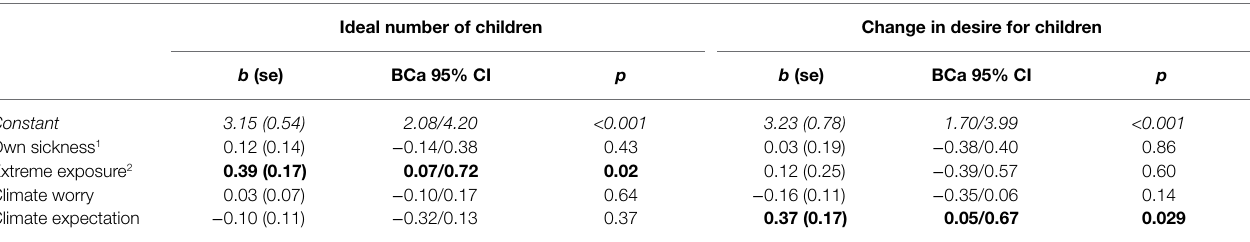
TABLE 2 | Summary of coefficients for full